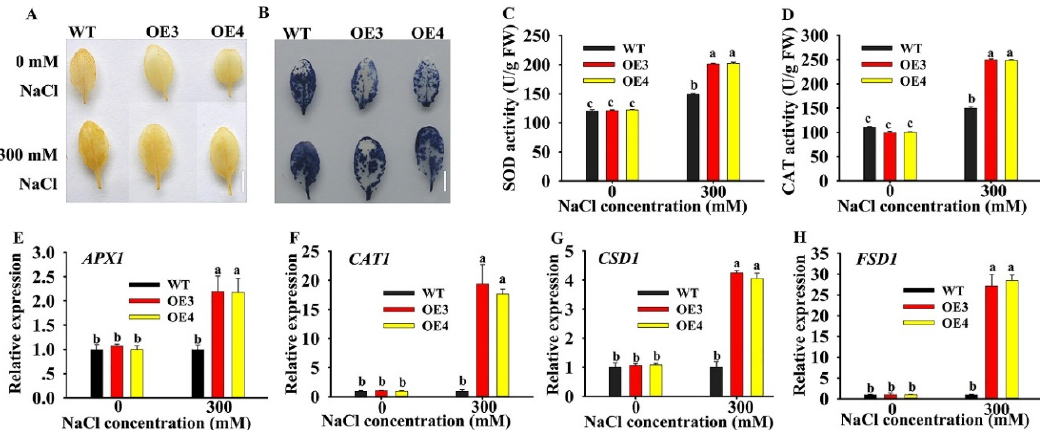
Figure 6. Oxidative stress analysis of HuERF1 -overexpressing Arabidopsis . (A, B) Staining assays were carried out to detect H 2 O 2 and O 2 · by DAB ( A ) or NBT ( B ) staining, respectively. ( C , D ) The activity of CAT and SOD under salt treatment for 24 h. ( E–H ) Expression levels of the reactive oxygen species-related genes under salt stress for 24 h based on qRT-PCR. AtAct2 was used as the internal standard. Different letters ( C – F ) indicate a significant difference at p < 0.05, ANOVA followed by Fisher’s LSD test. Mean values and SDs of three biological replicates are shown. Bars = 1 cm.